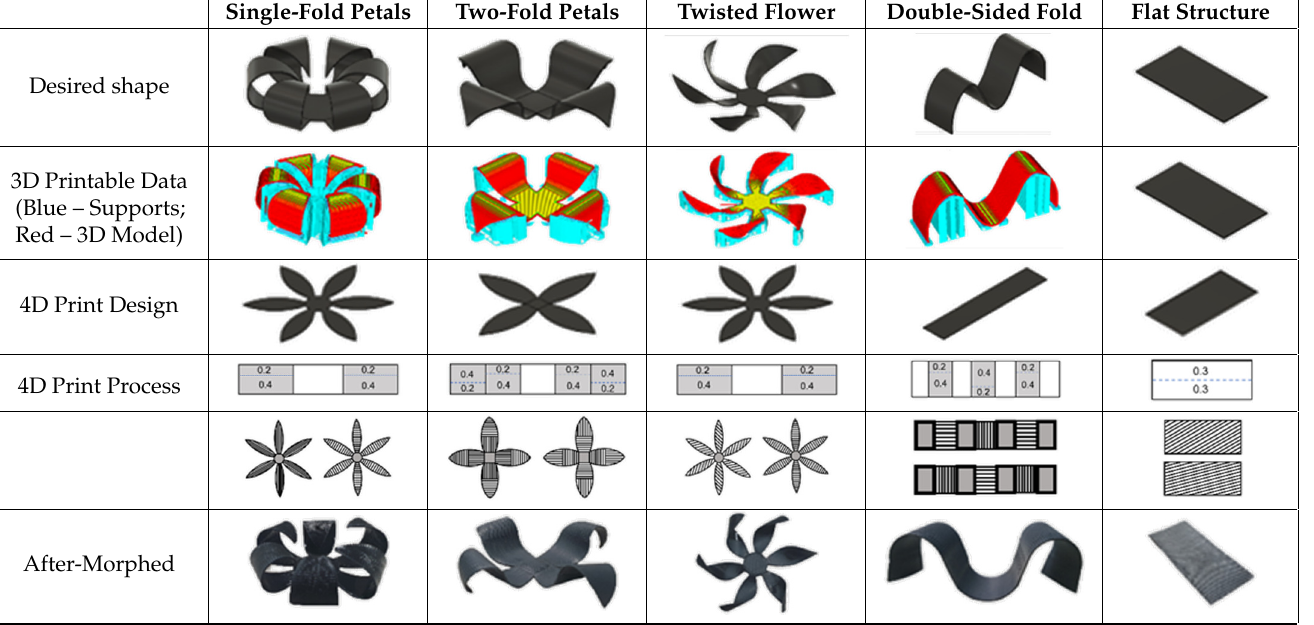
Table 5. AM-ed Structures for Self-morphing Applications in comparison to Traditional 3D Prints.